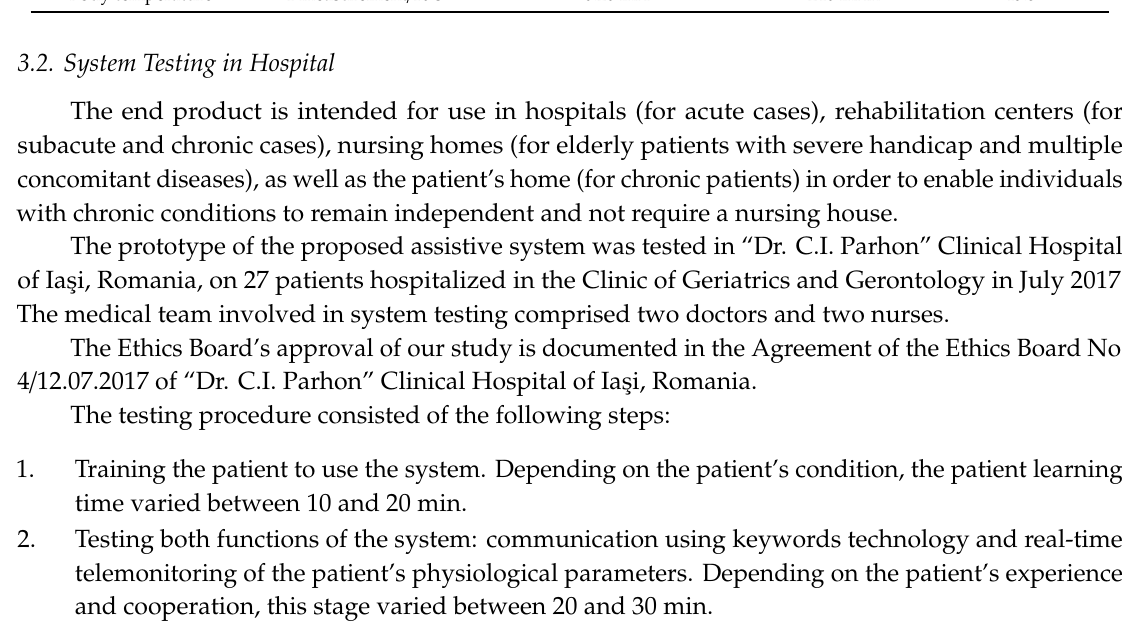
Figure 22. Evaluation of energy consumption.